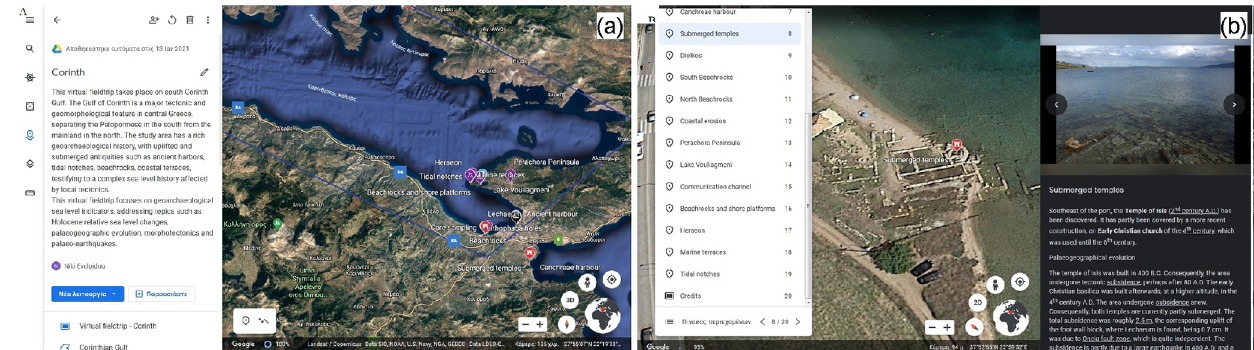
Figure 2. (a, b) Examples of the virtual field trip developed on the Google Earth platform. © Google Earth 2021.